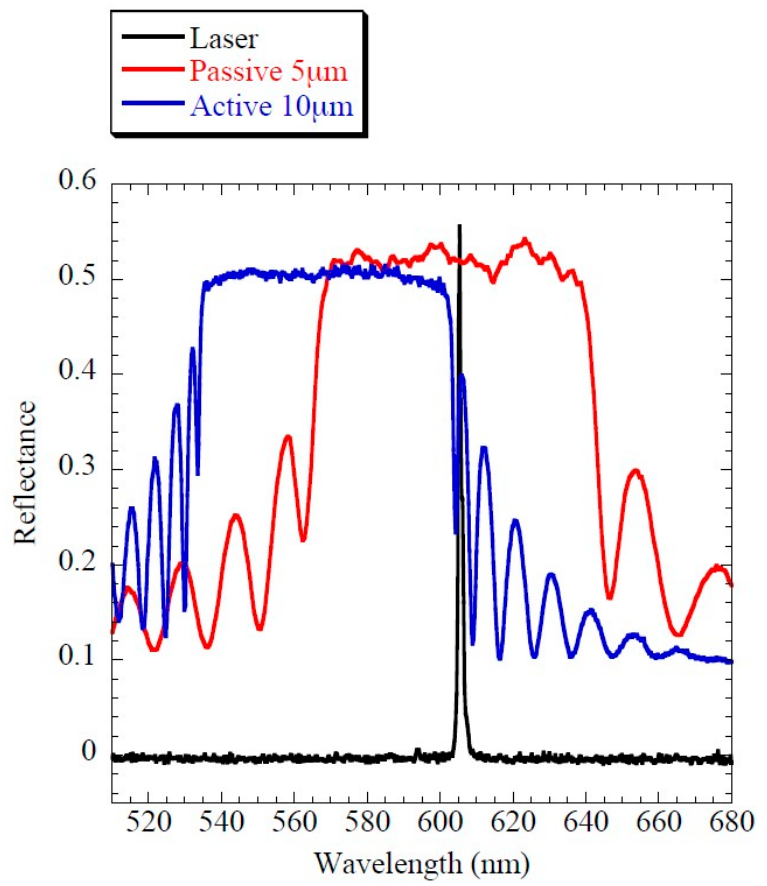
Figure 6. Reflectance and laser emission spectra of the CLC cells used in the experiments. In the case of the active cell, the reflectance measurements were carried out before adding the dye.